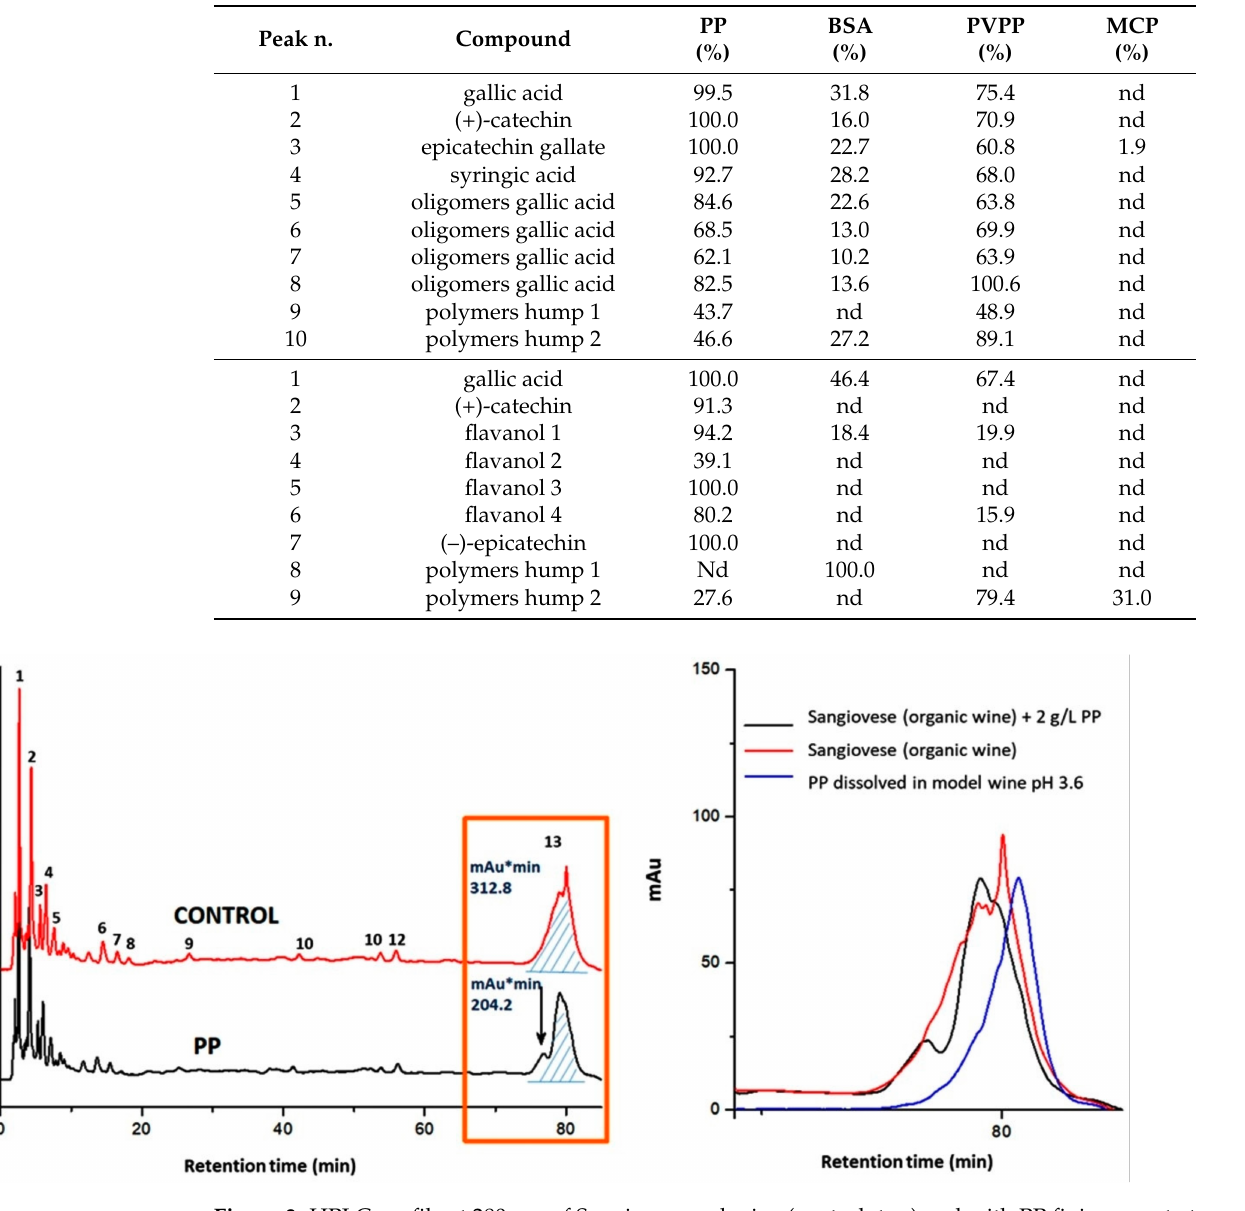
Figure 3. HPLC profile at 280 nm of Sangiovese red wine (control: top) and with PP fining agent at 2 g/L (bottom), with highlight on the hump of polymeric phenolic eluting at approx. 80 min (box on the right